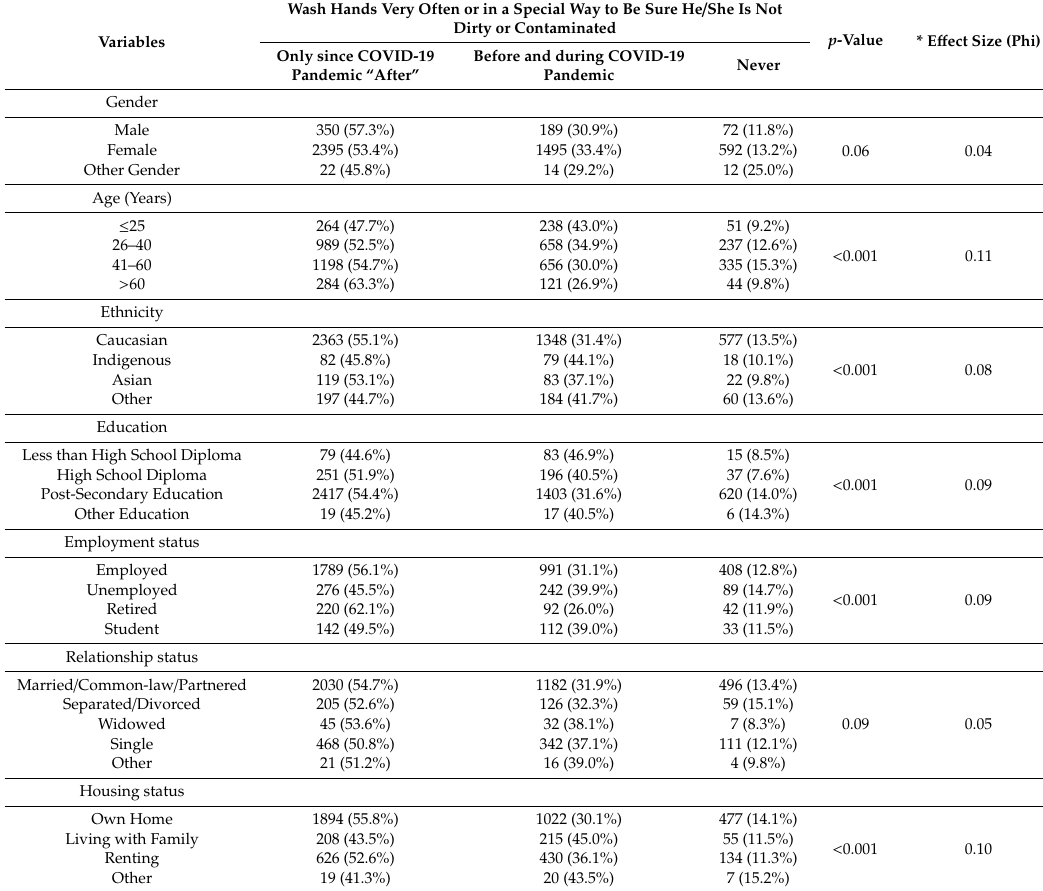
Table 3. Demographic characteristics of respondents with compulsive symptoms (repeated hand washing).